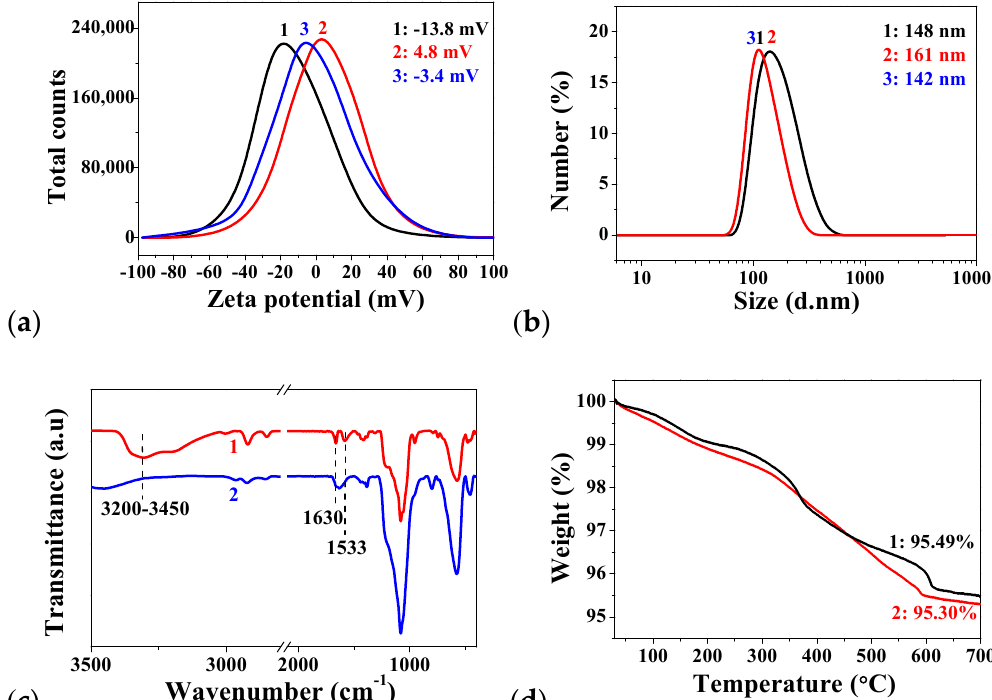
Figure 2. ( a ) Zeta potential and ( b ) DLS traces of Fe 3 O 4 @epoxide NP (1), Fe 3 O 4 @TAEA NP (2), and Fe 3 O 4 @Me 6 TREN NP (3); ( c ) FT-IR spectra of Fe 3 O 4 @TAEA NP (1) and Fe 3 O 4 @Me 6 TREN NP (2); ( d ) thermogravimetric analysis (TGA) curves of Fe 3 O 4 @epoxide NP (1) and Fe 3 O 4 @ Me 6 TREN NP (2).